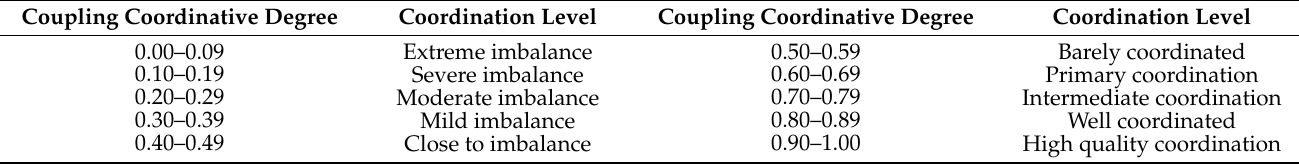
Table 2. The classification criteria of coupling coordinative